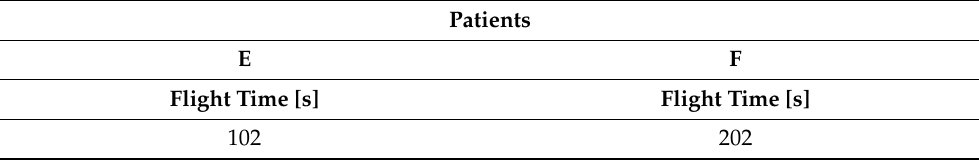
Table 13. Results of the patients’ flight times in the principal outdoor